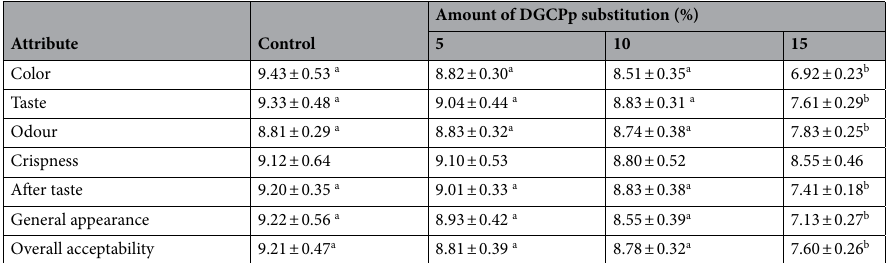
Table 5. Sensory quality attributes of crackers. Data are expressed as mean ± SEM. Mean values with different superscript letters [a (the highest values) and b (the lowest value)] in the same row are significantly different at ( p ≤ 0.05). All groups were compared to each